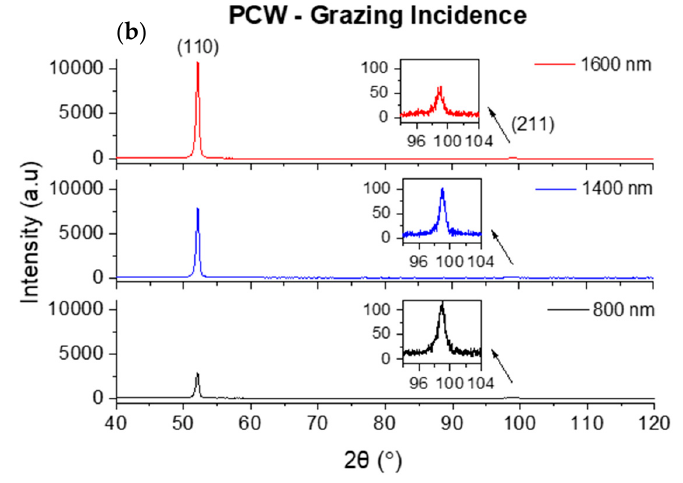
Figure 7. GIXRD patterns for different thicknesses of Cr films deposited over: ( a ) PCB and ( b ) PCW.